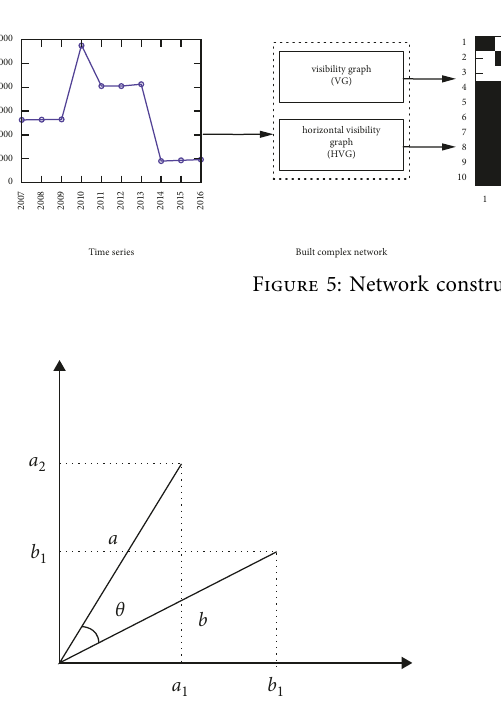
Figure 6: Cosine